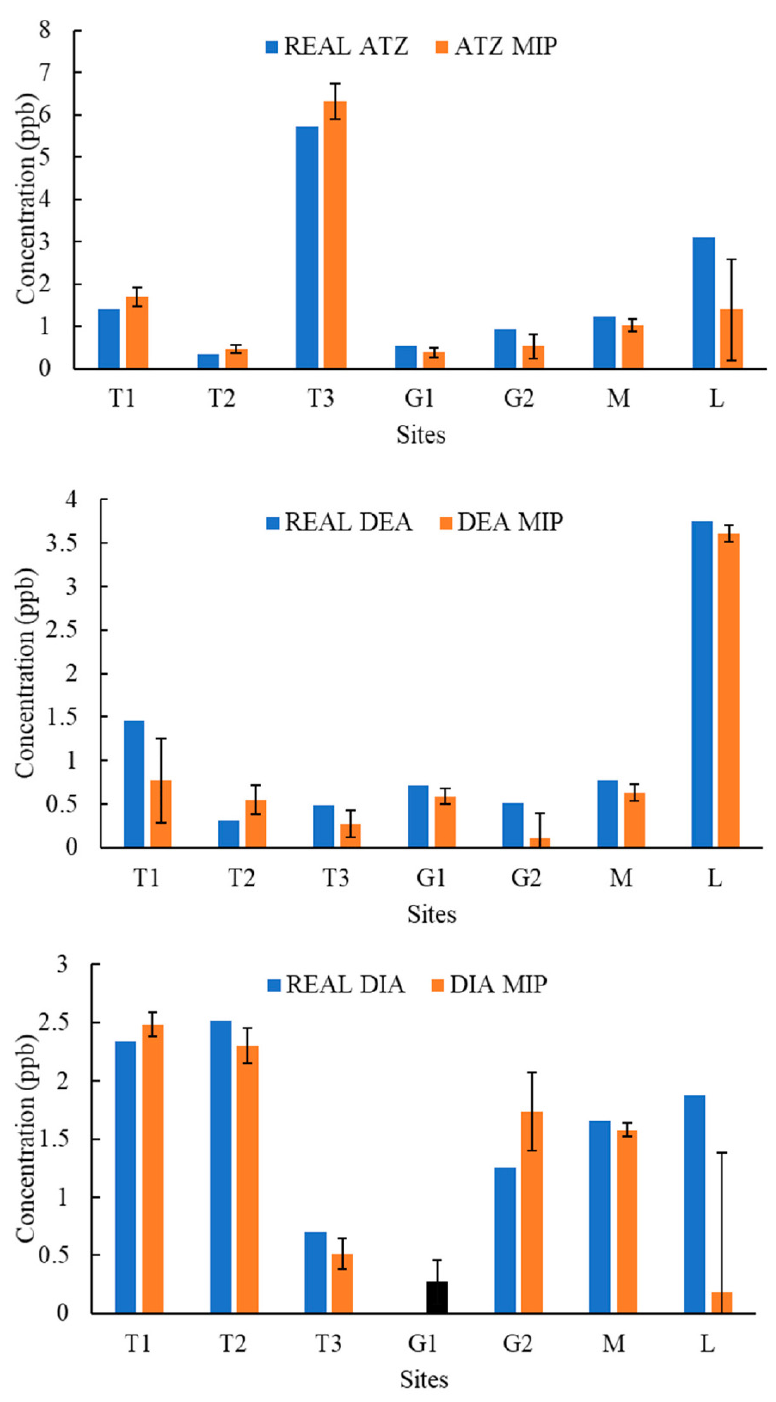
Figure 10. Average response of MIPs to ATZ, DEA, and DIA compared to real concentrations validated by LCMS/MS for samples of 24 April 2021.